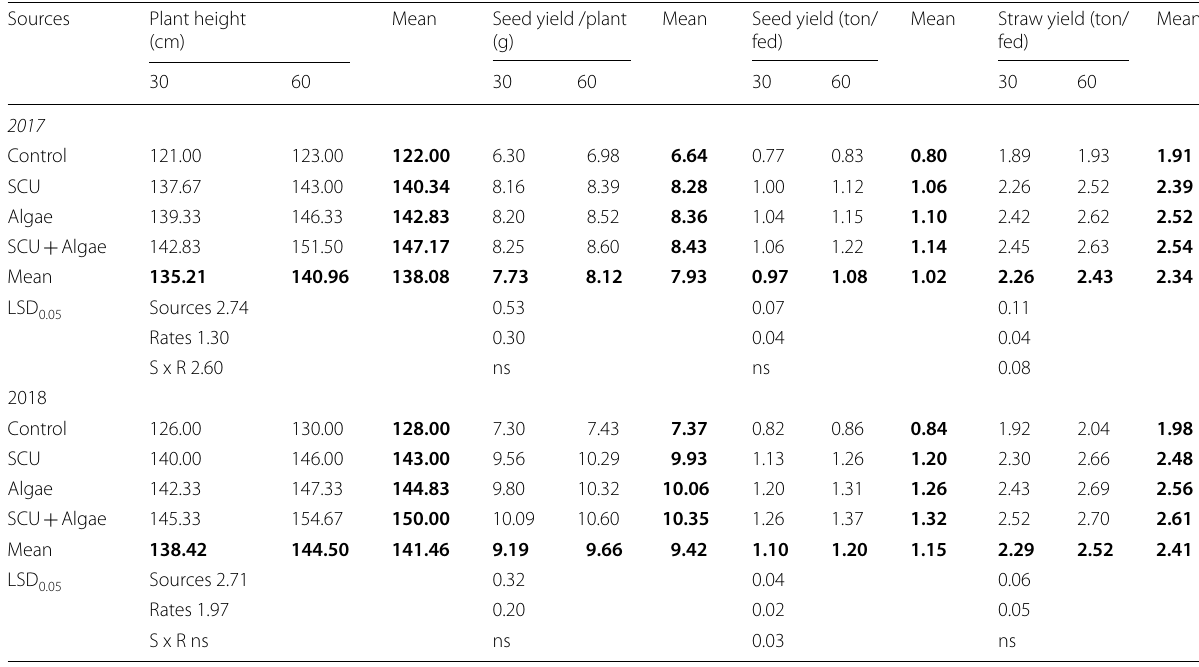
Table 8 Effect of algae and sulfur-coated urea fertilizers on yield and yield component of mungbean